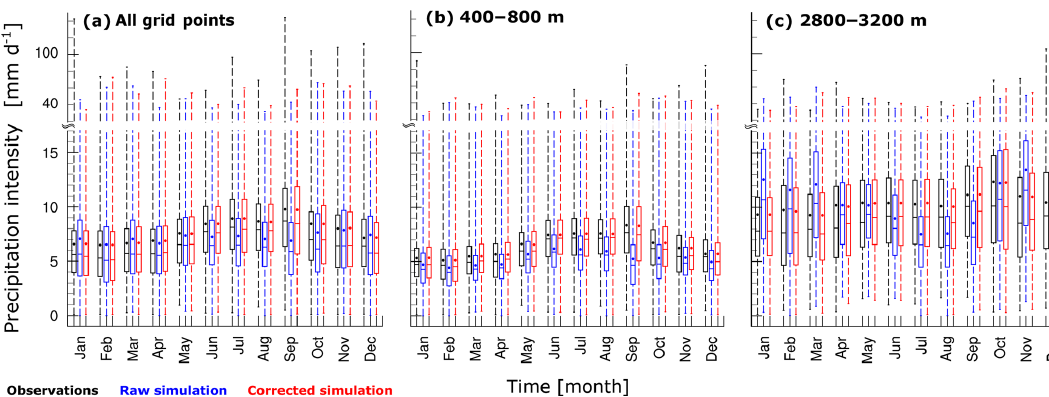
Figure 5. Boxplots illustrate the spatial distribution of monthly mean values of precipitation intensity across a specific area within 30 years: (a) the area covers all grid points over entire Switzerland, (b) the grid points in the height class of 400–800m, and (c) the grid points in the height class of 2800–3200m. Black box plots represent the observations (RhiresD); blue and red ones the raw and corrected simulations, respectively. Top and bottom ends of the dashed lines represent the maximum and minimum values, respectively. Dots represent the spatial climatological mean